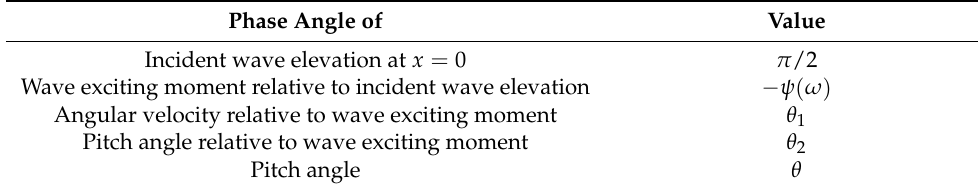
Table 1. The phase angles of various items for regular waves. Phase Angle of Value Incident wave elevation at x = 0 π